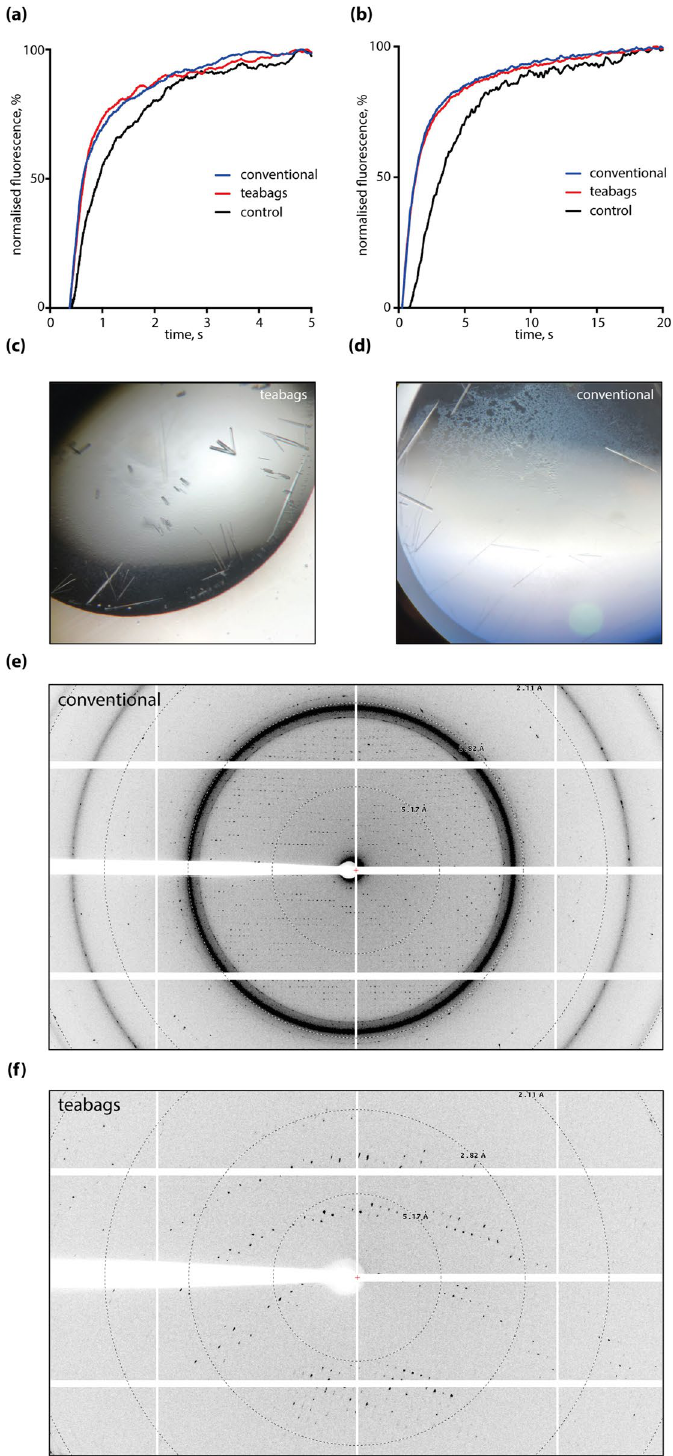
Figure 4. Quality assessment of purified hAQP10 using a liposome assay and crystallization. ( a ) Water efflux assay of hAQP10 reconstituted proteoliposomes. Almost identical traces of conventional (blue) and teabag (red) purified samples, using empty liposomes as control (black); ( b ) glycerol efflux assay of hAQP10 reconstituted proteoliposomes. Almost identical traces of conventional (blue) and teabag (red) purified samples, using empty liposomes as control (black); ( c ) crystals produced from teabag purified hAQP10, showing rod-shaped crystal morphology; ( d ) crystals produced from conventionally purified hAQP10, showing needle-shaped crystal morphology; ( e ) diffraction pattern of conventionally purified hAQP10, showing a diffraction to approximately 2 Å; ( f ) diffraction pattern of teabag purified hAQP10, showing a diffraction to approximately 2